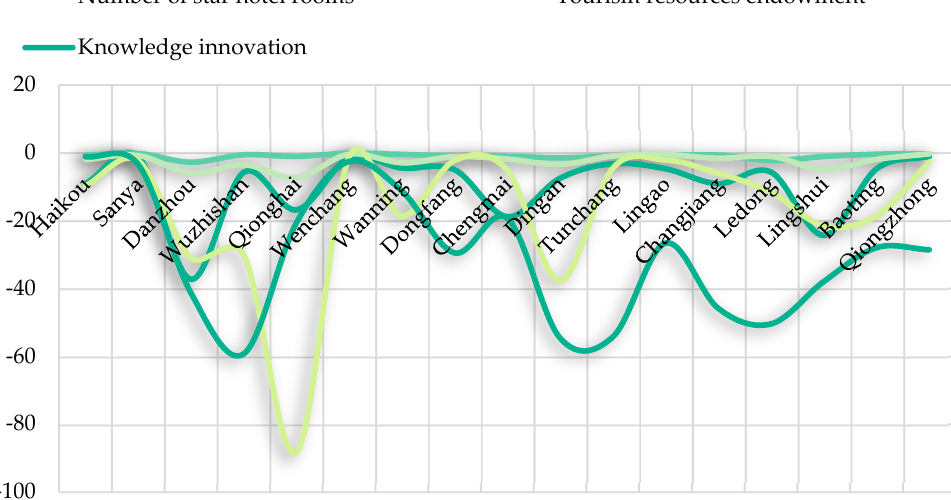
Figure 3. Potential indicators of tourism development efficiency improvement in Hainan cities from 2001–2020.